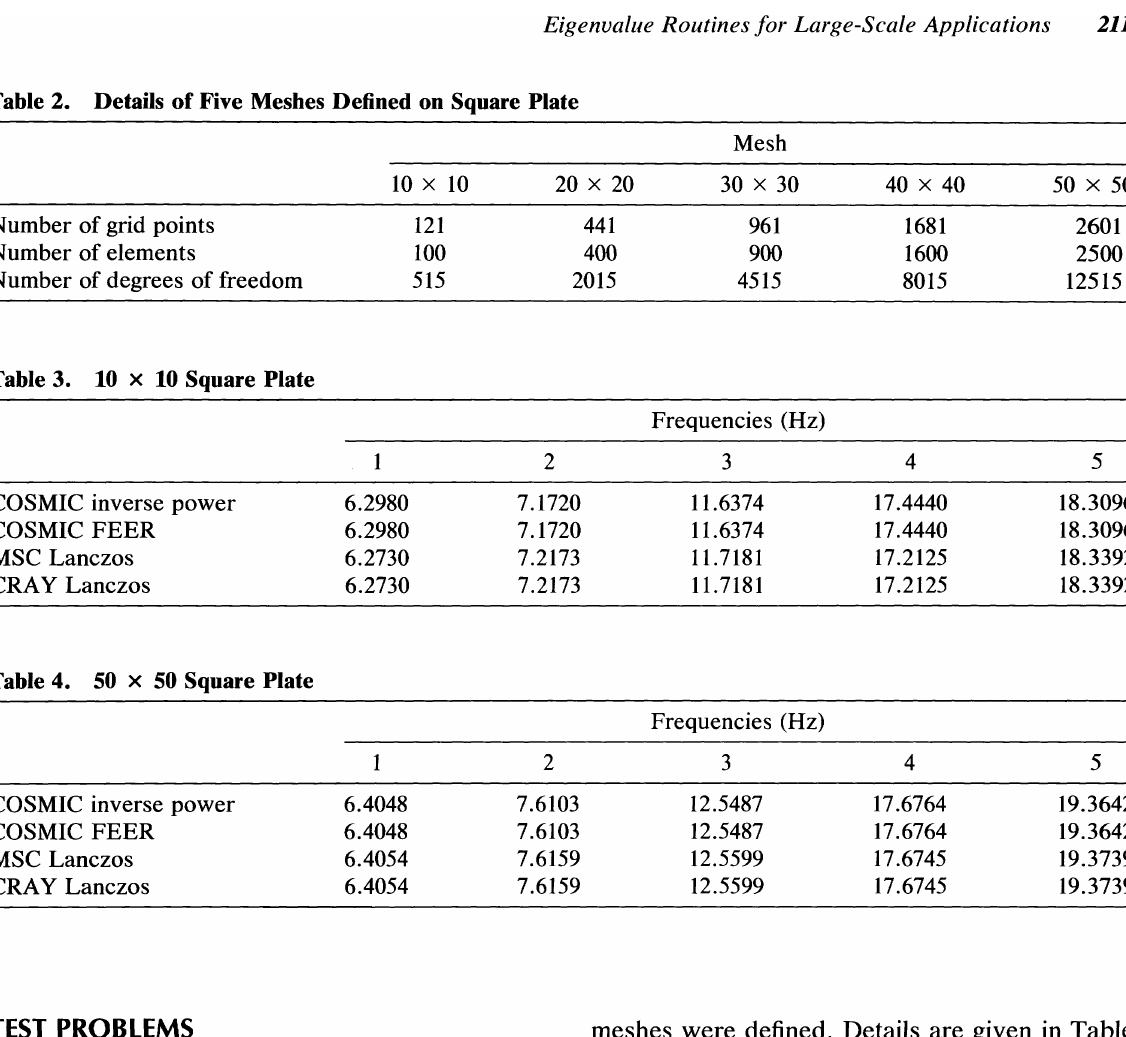
Table 3. 10 x 10 Square Plate